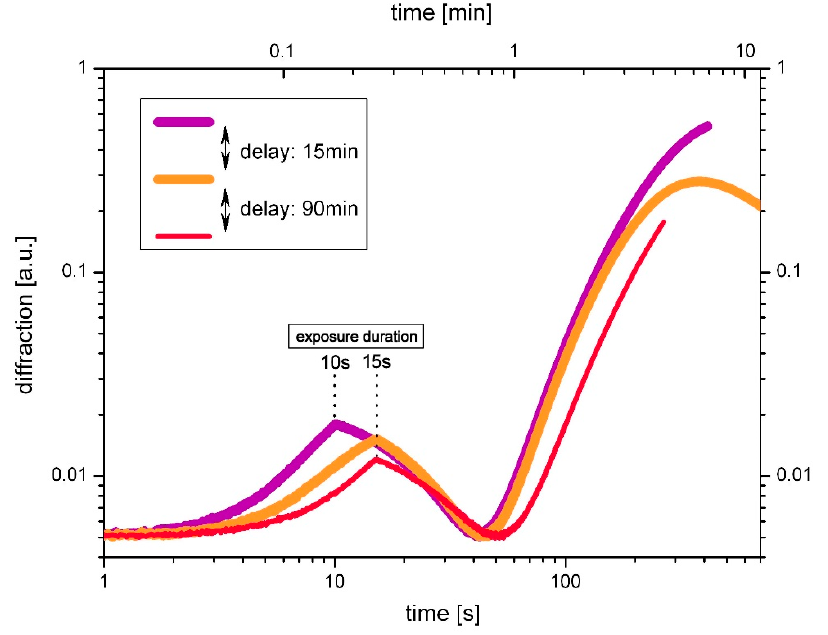
Figure 3. Impact of the pre-exposure on the grating growth in the undoped SU-8. Exposure duration was 10 s (violet curve) and 15 s (red and orange curve), respectively.